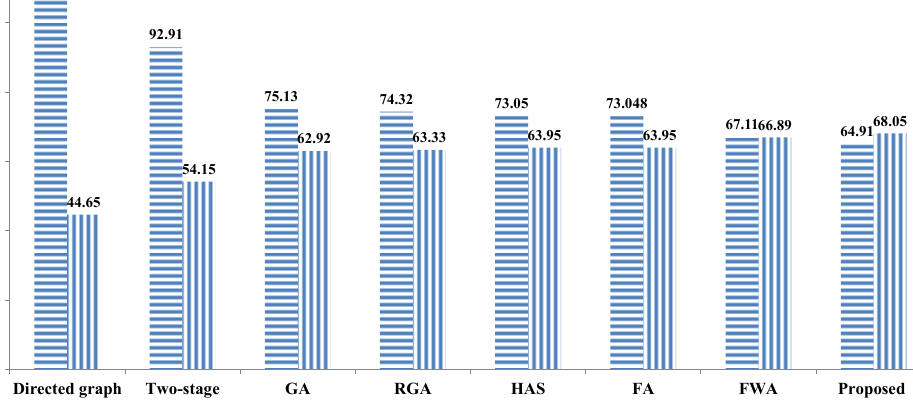
Figure 10. Comparison of active power loss reduction (%) by proposed method and other tech- niques.